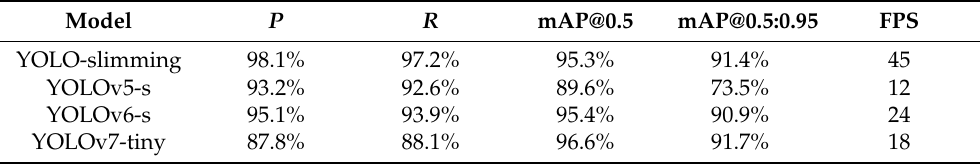
Table 5. Real-time test